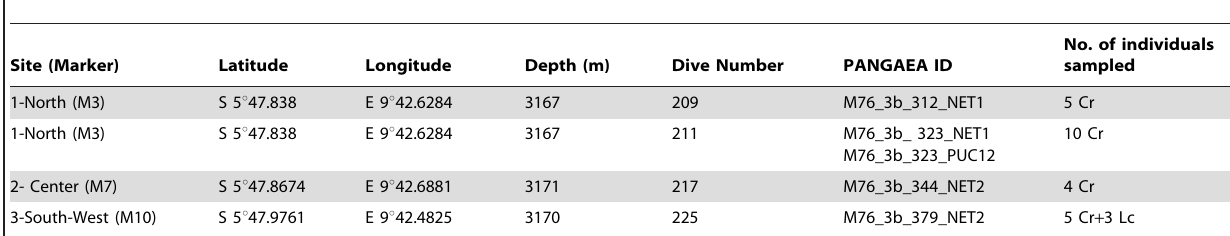
Table 1. Study sites at the Regab pockmark and number of individuals sampled (Cr: Christineconcha regab and Lc: Laubiericoncha chuni